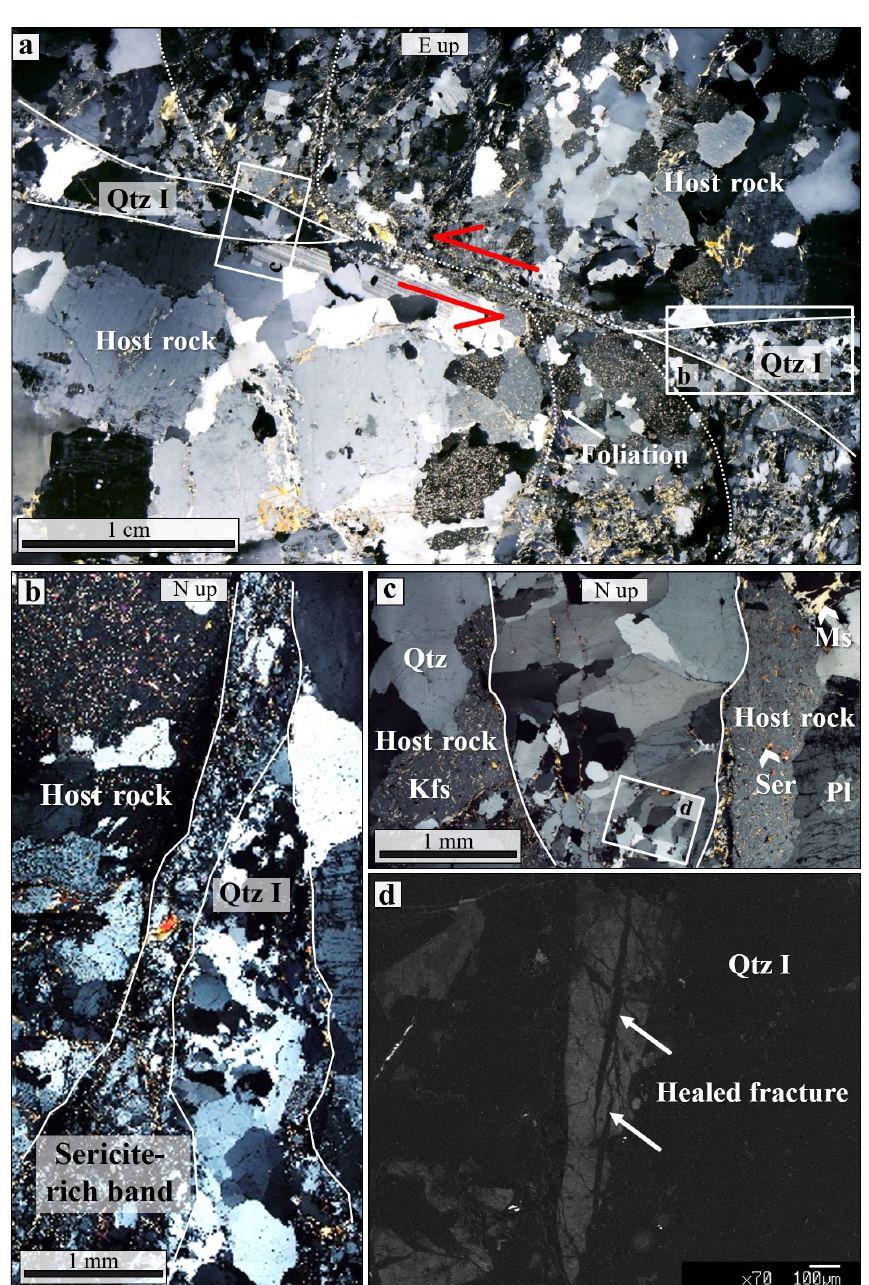
Figure 4. Microtextural characteristics of Qtz I from the damage zone of BFZ300 (sample: TPH-120-2). (a) Stitched photomicrographs of a Qtz I vein interconnecting with a sinistral shear band (crossed nicols). Faulting kinematics is suggested by drag folds in the host rock. (b) Tip of Qtz I vein hosted by a sericite-rich cataclastic band of the host rock. (c) Detail of panel (a) showing open-space filling texture in the Qtz I vein. Notice the sericite microfractures cross-cutting Qtz I. (d) Panchromatic cathodoluminescence image of Qtz I showing healed microfractures cross-cutting the